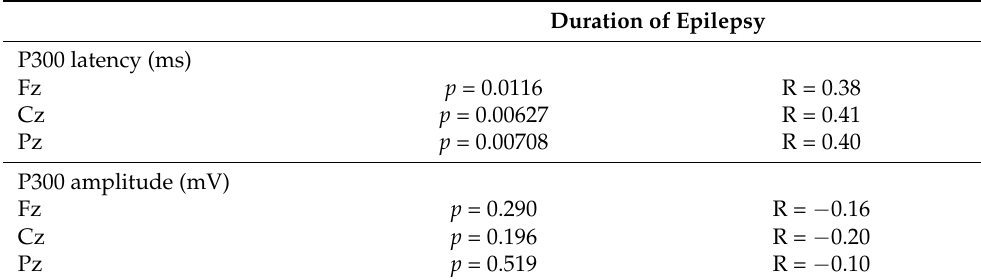
Table 5. Analysis of correlation between P300 parameters and duration of epilepsy in the study group (R—Spearman’s rank correlation coefficient).